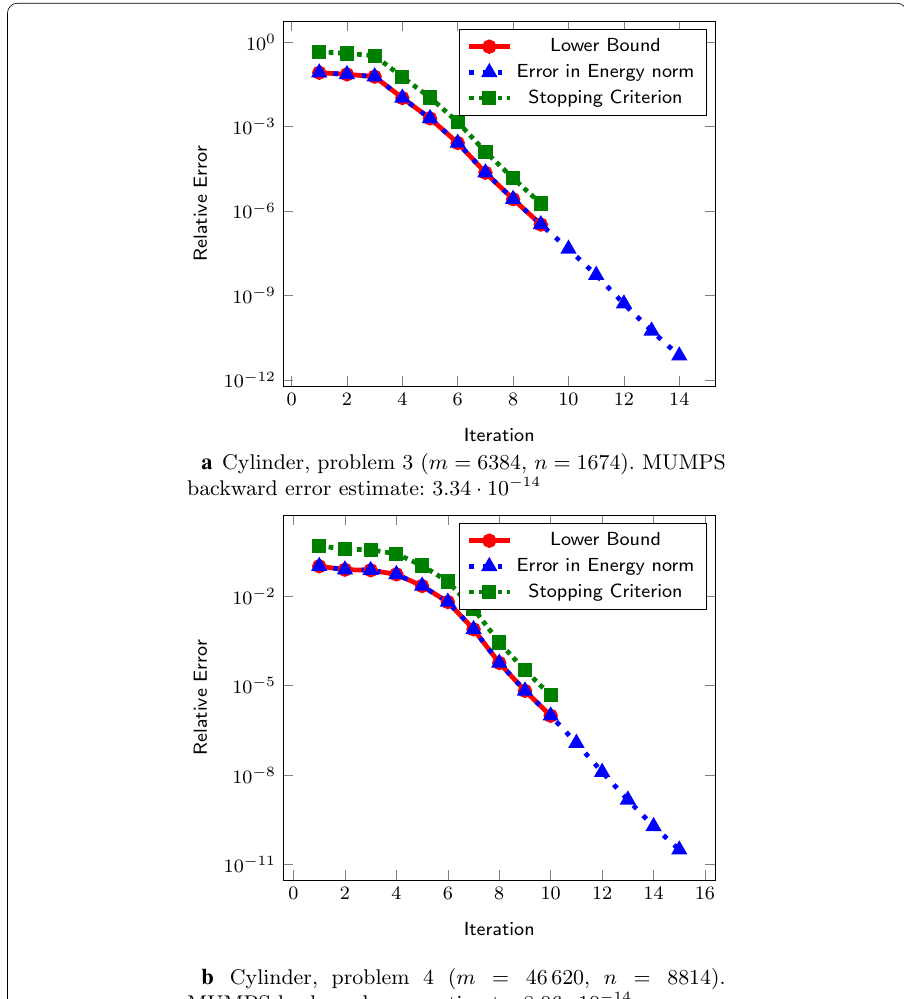
Fig. 4 Convergence of generalized GKB method for Cylinder problems 3 and